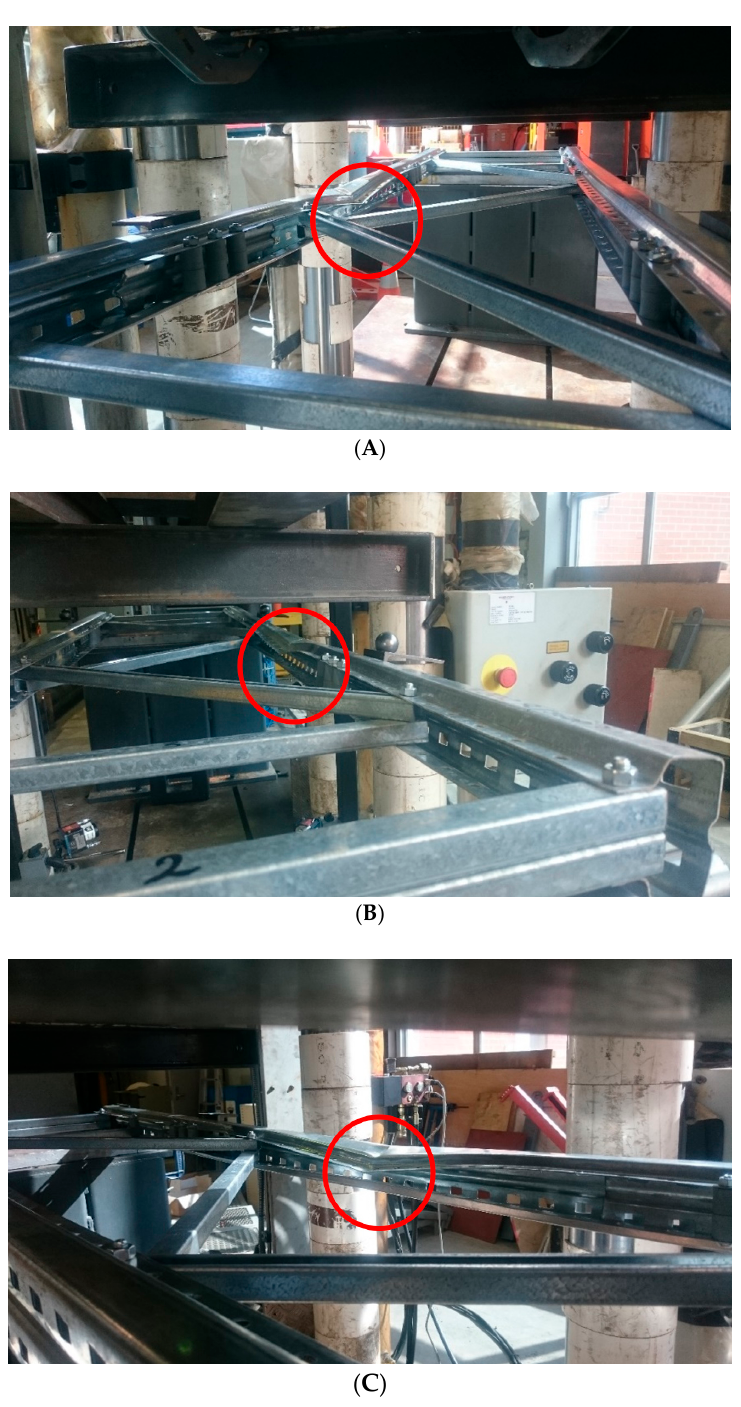
Figure 11. The observed failure mode for unreinforced specimens during the major axis test: ( A ) SMJM-test1; ( B ) SMJM-test2; ( C ) SMJM-test3.